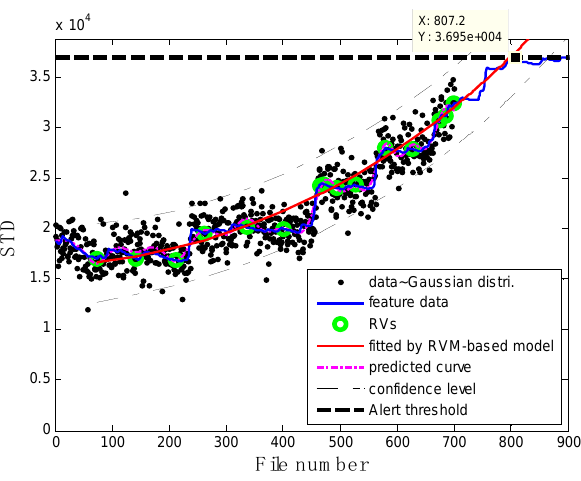
Figure 13. Inspection file number